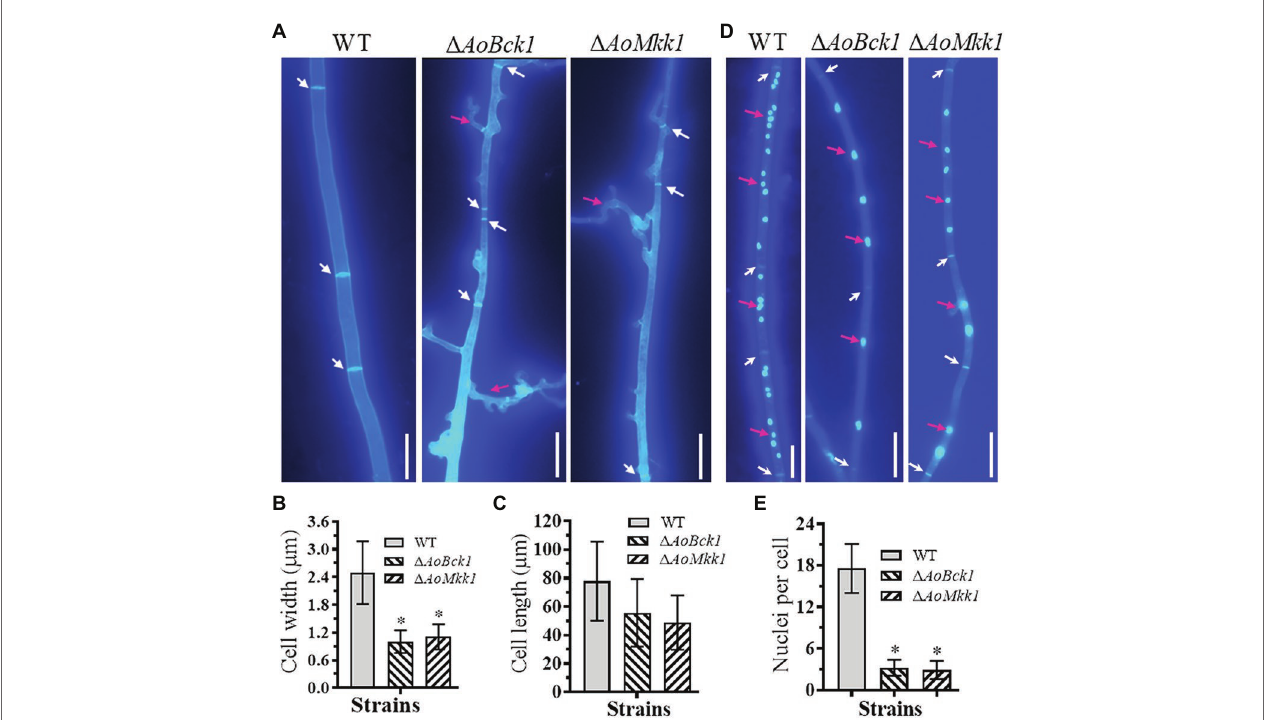
FIGURE 2 | Comparison of hyphal septum, branch, and cell nucleus between the WT and mutants. (A) Hyphal septa of the WT and mutants were stained with 20 μ g/ml calcofluor white (CFW) after the fungal strains were incubated on cornmeal-molasses-yeast (CMY) medium for 7 days. White arrows: hyphal septa; red arrows: hyphae branch. Bar = 10 μ m. (B) Comparison of mycelial width of each strain. (C) Comparison of mycelial cell length of the WT and mutants; 61 mycelial cells were randomly selected, and the width and length of hyphal cell were measured using ImageJ software. Error bars: SD from 61 replicates. (D) Hyphae of the WT and each mutant strain were stained with CFW and 4 ' ,6-diamidino-2-phenylindole (DAPI) after the fungal strains were grown for 7 days on CMY medium; samples were examined using an inverted fluorescence microscope. White arrows: septa; red arrows: cell nucleus. Bar = 10 μ m. (E) Comparison of mycelial cell nuclei between the WT and each mutant strain. Thirty hyphal cells were randomly selected for counting cell nuclei. Error bars: SD from 30 replicates; an asterisk indicates a significant difference compared to the WT ( p <